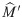

M^′ is shown; each of the entries in the regions marked with 0/1 may be 0 or 1.